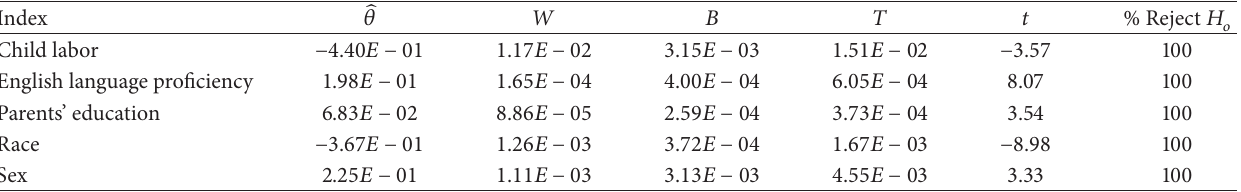
Table 1: Results of logistic regression substantive analyses on 10 imputed data sets. The far right column reports the percentage of the imputed data sets which resulted in rejecting the null hypothesis that the parameter is equal to zero versus the two-sided alternative. The other columns represent the parameter estimates and 𝑡 values for the 𝑡 -test described in Section 1.6. 𝑁 = 4649 , 𝑡 ∗ 9 (0.05) = 2.26 .